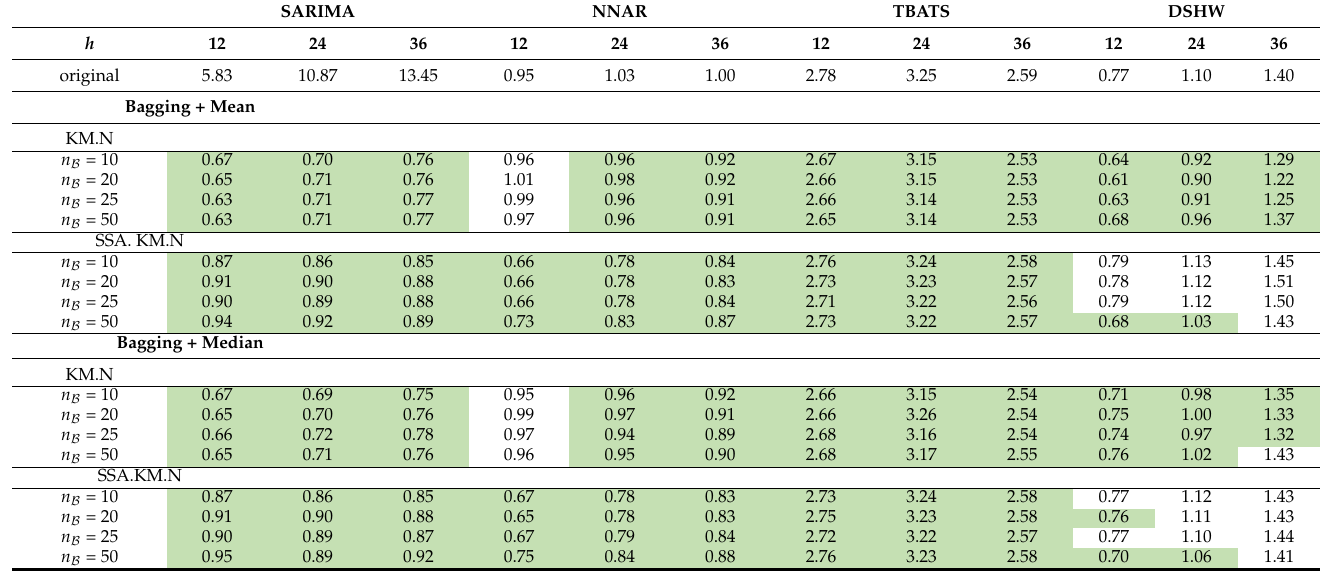
Table 13. MAPE of h -step ahead forecast for the hourly electricity load of Indonesia obtained by SARIMA, NNAR, TBATS, and DSHW models.